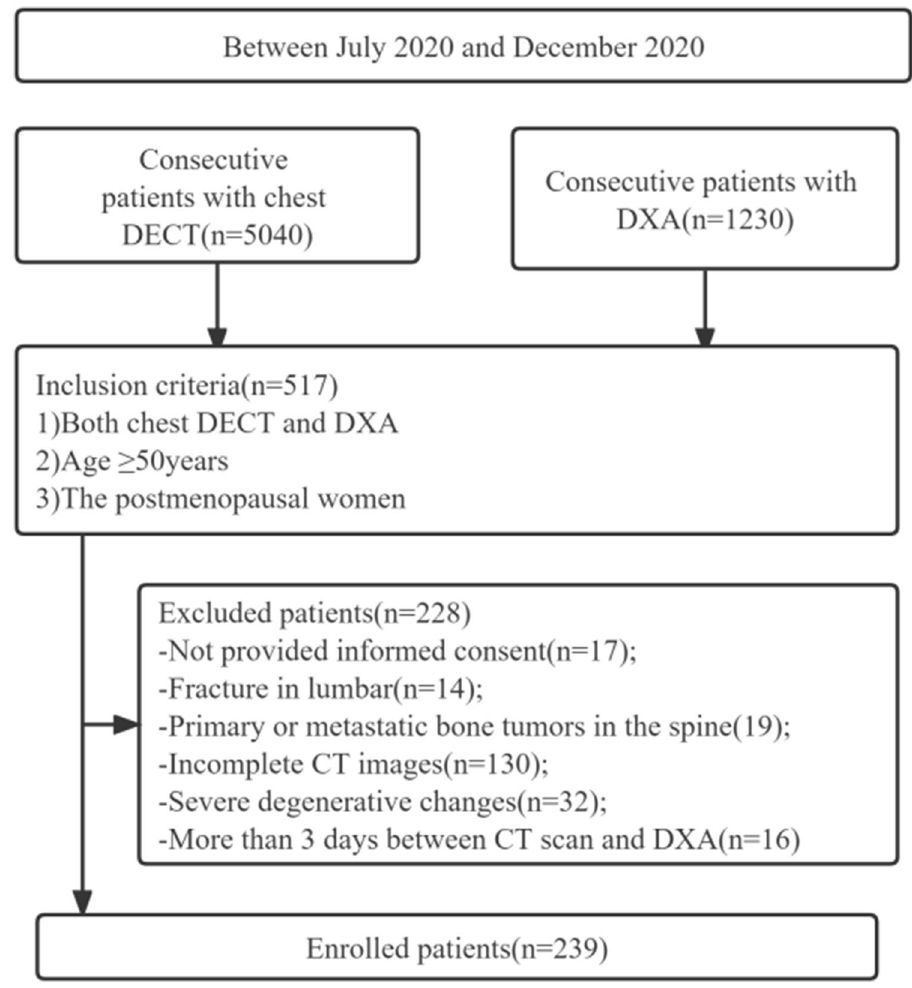
Figure 1. Flowchart of patient selection. DECT: dual energy CT, DXA: dual-energy X-ray